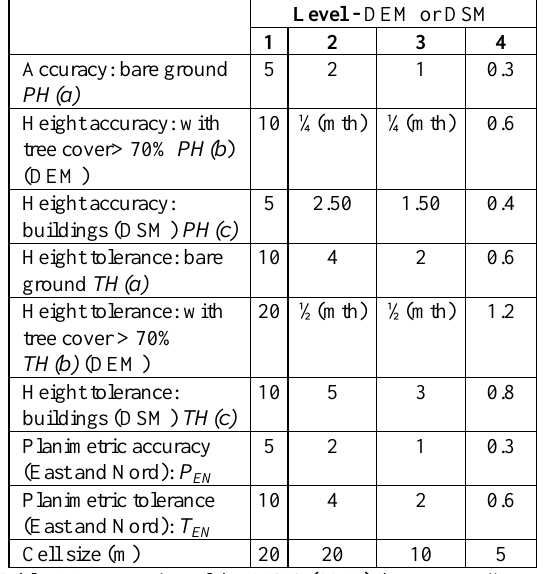
The table is not complete: higher level DEMs are